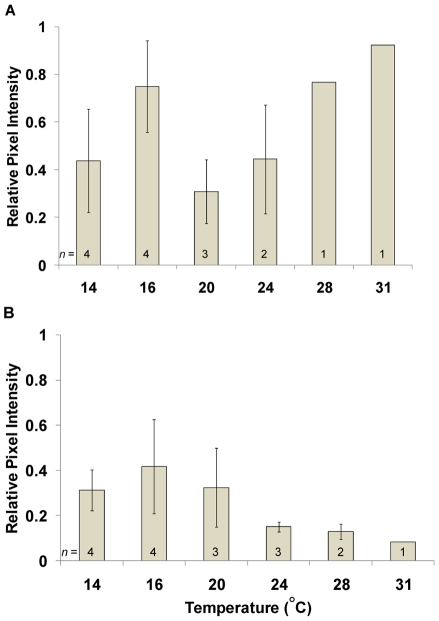
Level of heat-shock protein (Hsp70) in the invasive Diplosoma (A) and native Distaplia (B).Total Hsp70 (shown as mean [±1 SE] immunoblot pixel intensity relative to an internal standard) in Diplosoma (A) and Distaplia (B) individuals after a 24 h exposure to 6 treatment temperatures and a 48 h recovery period at ambient temperature. Sample sizes are shown at the base of the columns.